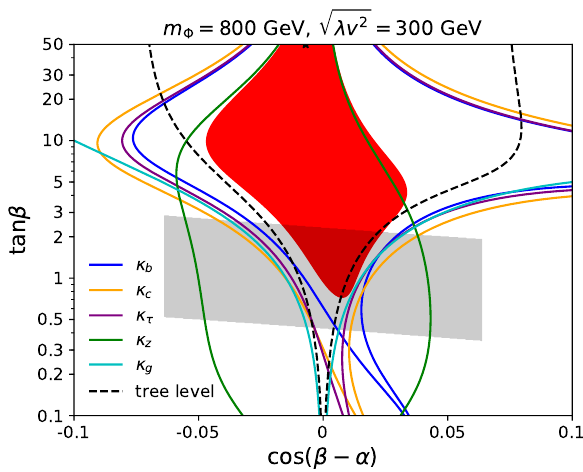
(cid:11) ) tan (cid:12) (cid:0) (cid:0)